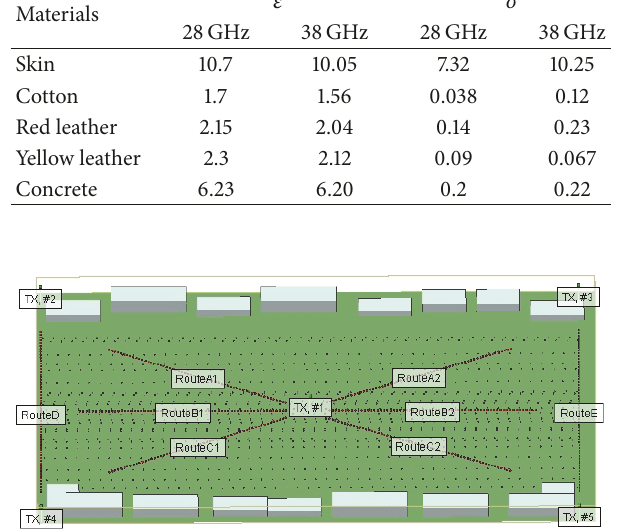
Figure 2: Similarity to the station square simulation